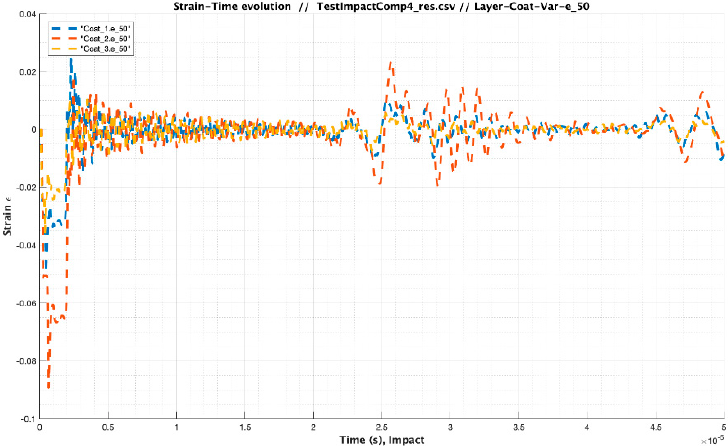
Figure 28. Strain-Time evolution for Case 1,2,3 at middle coating layer, 50% thickness, considering the substrate-filler as semi-infinite with variation in coating modulus.